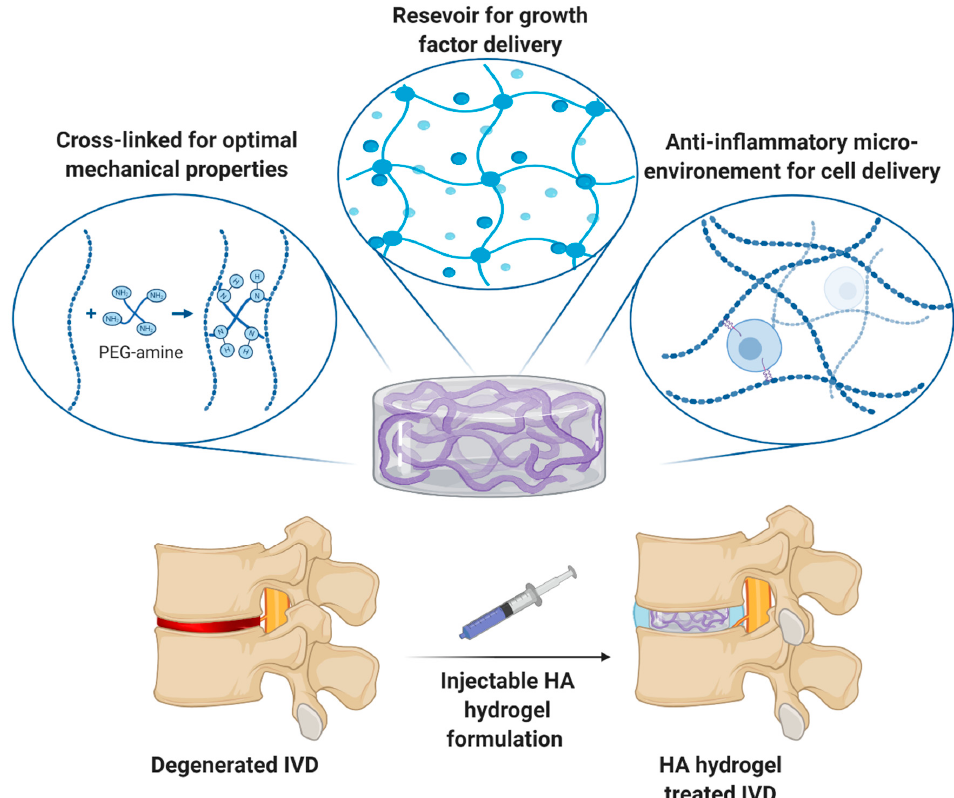
Figure 1. Different hyaluronic acid-based hydrogel platforms to treat the intervertebral